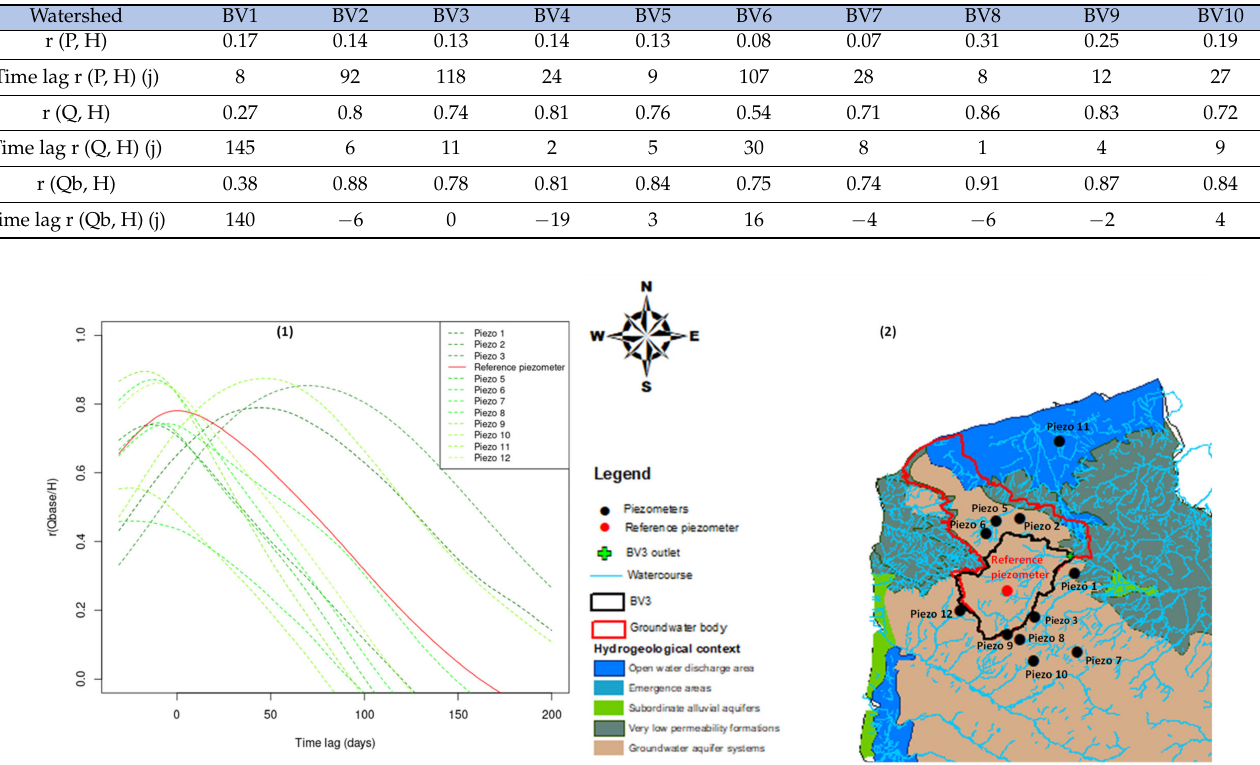
Figure 3. Selection method results for piezometric station most representative of the water table—river exchanges for BV3. (1) Correlation curves between watershed base flows and the piezometer chronicle for the 12 closest selected piezometers. (2) Location